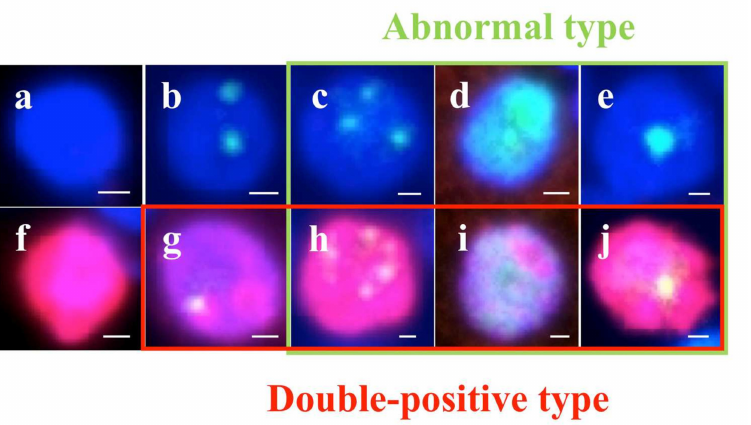
Figure 4. Types of TP53-binding protein 1 (53BP1) expression (green) by dual-color immunofluores- cent analysis with Ki-67 expression (red). Stable type, no or faint nuclear staining ( a , f ); low DNA damage response (DDR) type, one or two discrete nuclear foci (NF) ( b , g ); high DDR type, three or more discrete NF ( c , h ); diffuse type, intense heterogeneous nuclear staining ( d , i ); and large NF type: discrete nuclear foci, which are larger than 1.0 µ m ( e , j ). Photos surrounded by green line indicate abnormal type 53BP1 expression, and photos surrounded by red line indicate co-expression of 53BP1 and Ki-67. The scale bars indicate 2 µ